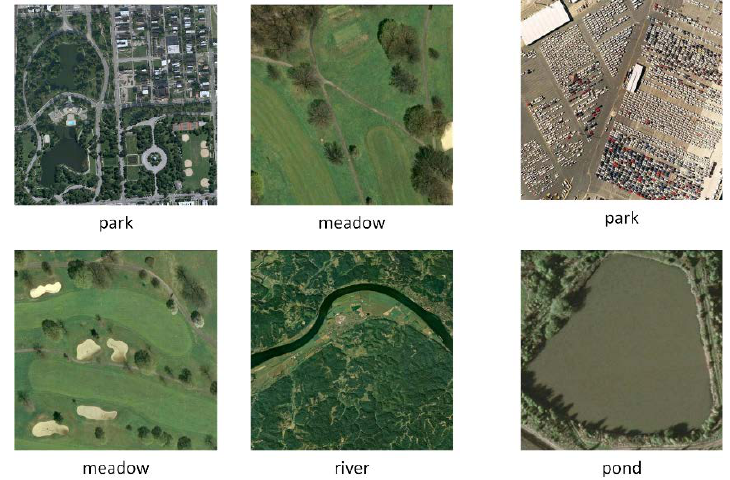
Figure 13. Several example images that compare results from CCP-net and SPP-net on the WHU-RS dataset. Images, where SPP-net failed, are shown in the first two columns and images where CCP-net failed are shown in the last column.